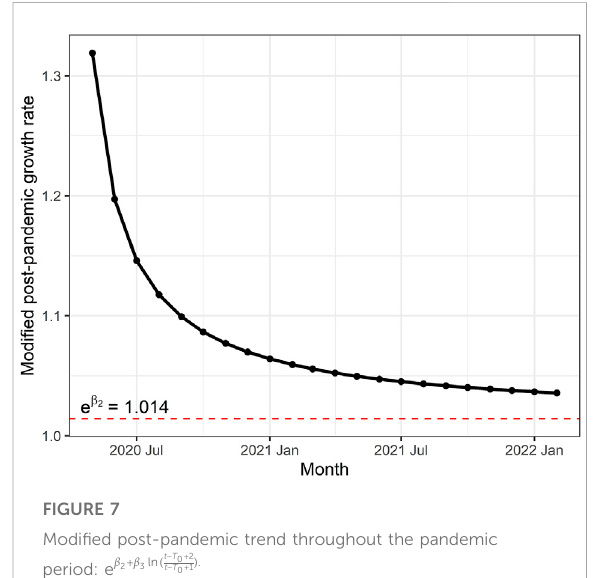
Modi fi ed post-pandemic trend throughout the pandemic